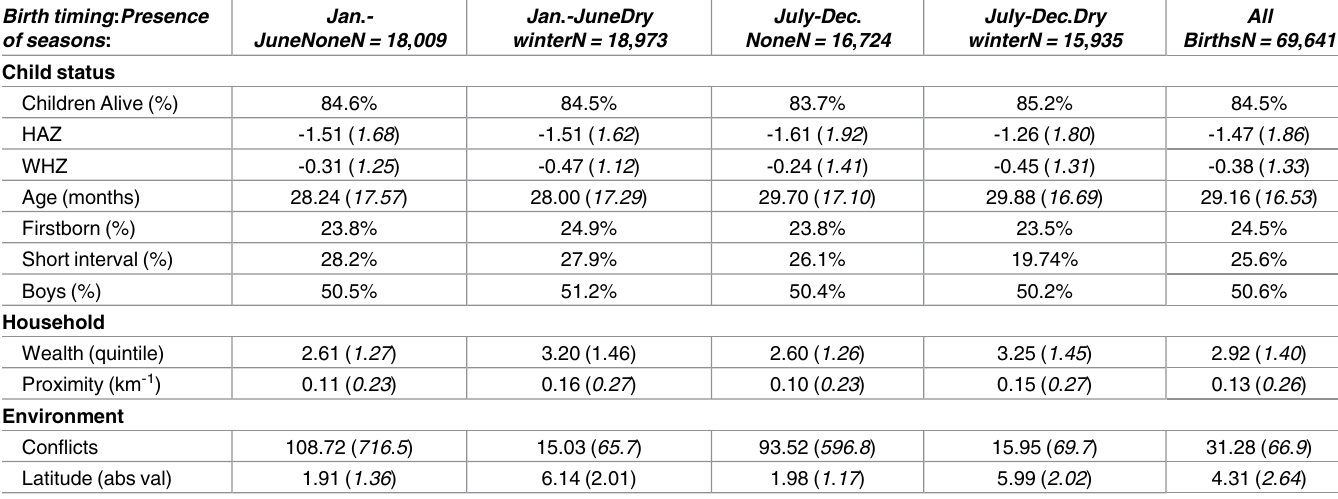
Table 2. Descriptivestatistics by birth timing and exposure to seasonal